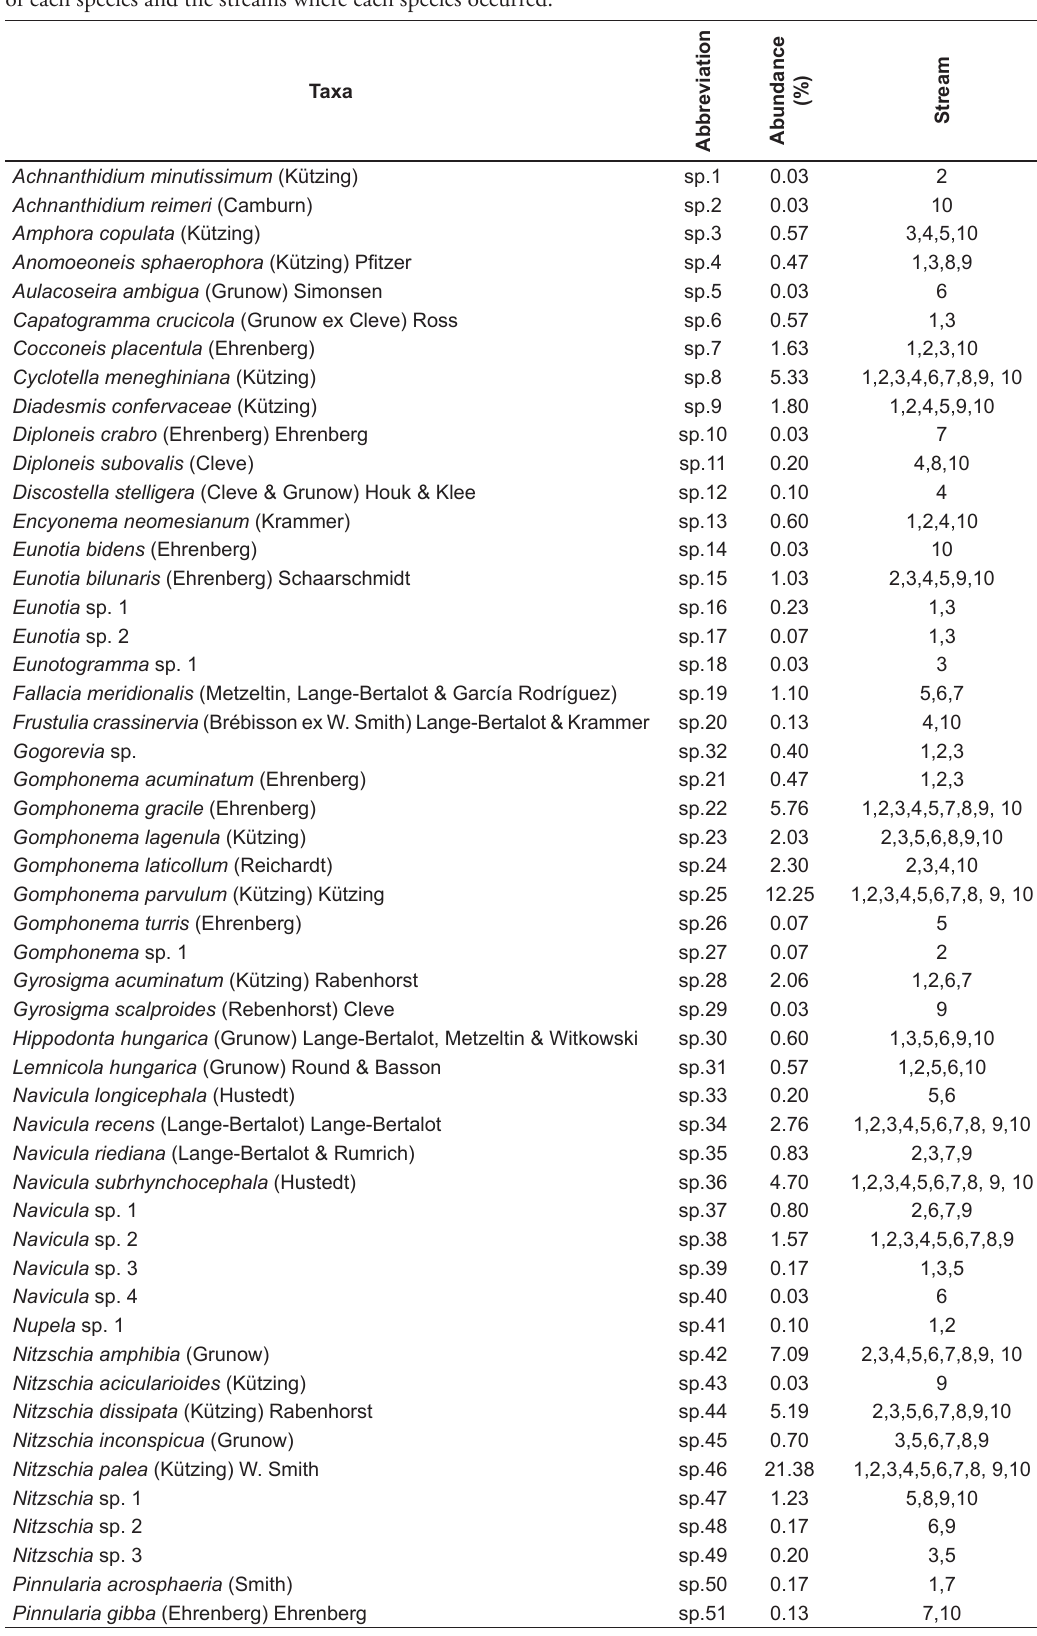
Table 2. List of diatom taxa found in 10 coastal streams on southernmost Brazil, indicating the relative abundance of each species and the streams where each species